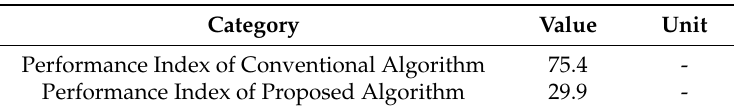
Figure 15. Error compared to reference value to each algorithm. Table 5. Performance Index of each algorithm.